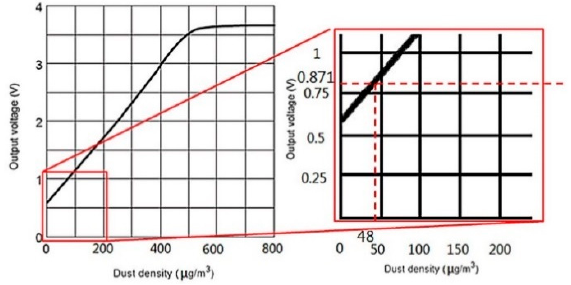
Figure 17. Diagram of particulate matter sensor data and voltage function [33].